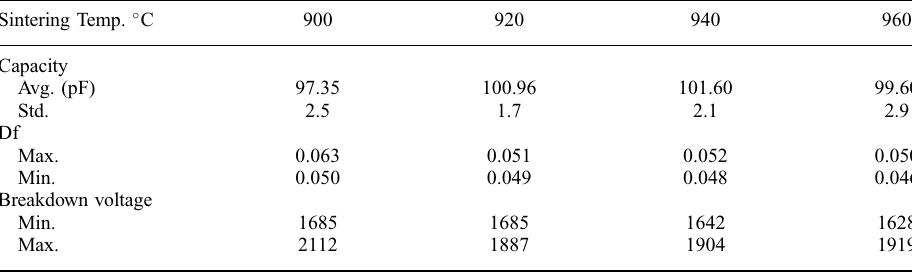
TABLE III Comparison of Electrical Performance at Different Sintering Temperatures, Ag = Pd 95 = 5.